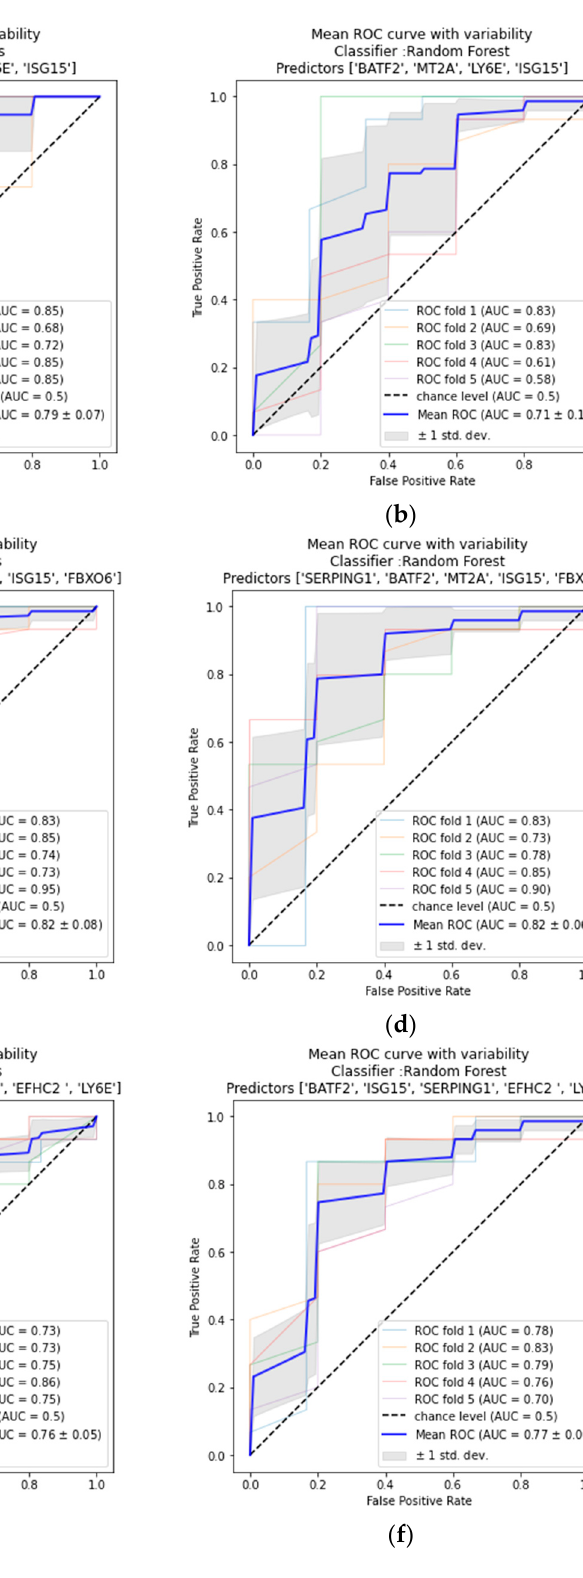
Figure 3. Results of mean ROC curve with variability for different predictors: #1, #3 and #5, based on our ML models. Predictor #1 ( a ) Extra Trees classifier, ( b ) Random Forest classifier. Predictor #3 ( c ) Extra Trees classifier, ( d ) Random Forest classifier. Predictor #5 ( e ) Extra Trees classifier, ( f ) Random Forest classifier. Each ROC AUC consists of a 5-StratifiedKFold average.